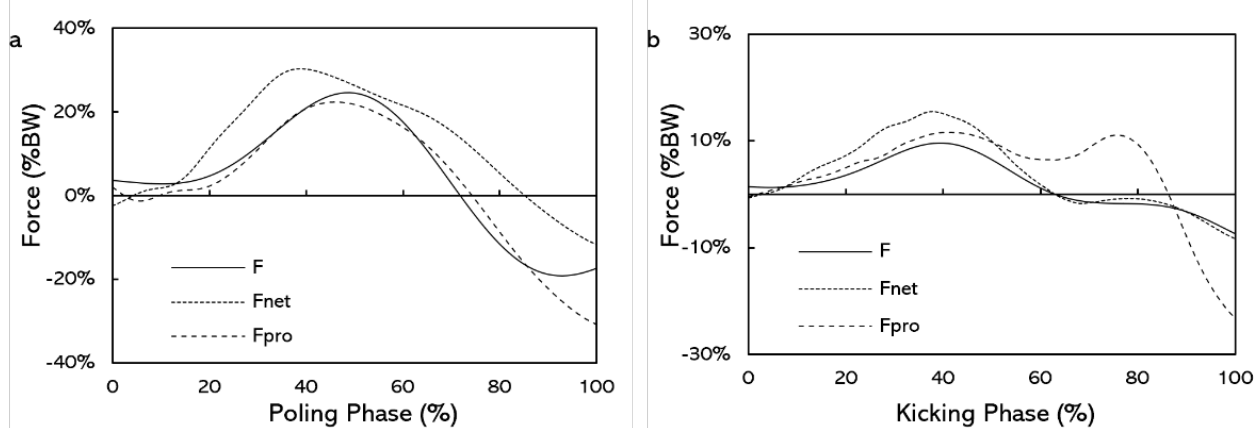
Figure 6. Force-time curves of F, F net , and F pro : ( a ) DP technique. ( b ) V2 technique. Values are averaged over 10 force-producing phases of one subject from each technique (speed of the treadmill was 19 km/h; incline of the treadmill was 2°).